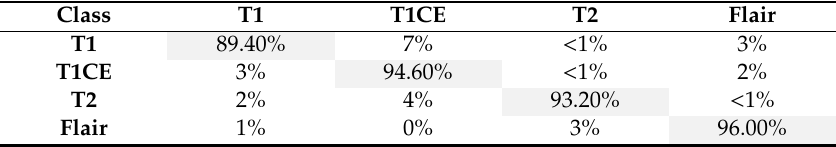
Table 8. Confusion matrix of the proposed method for the BraTS 2017 dataset.